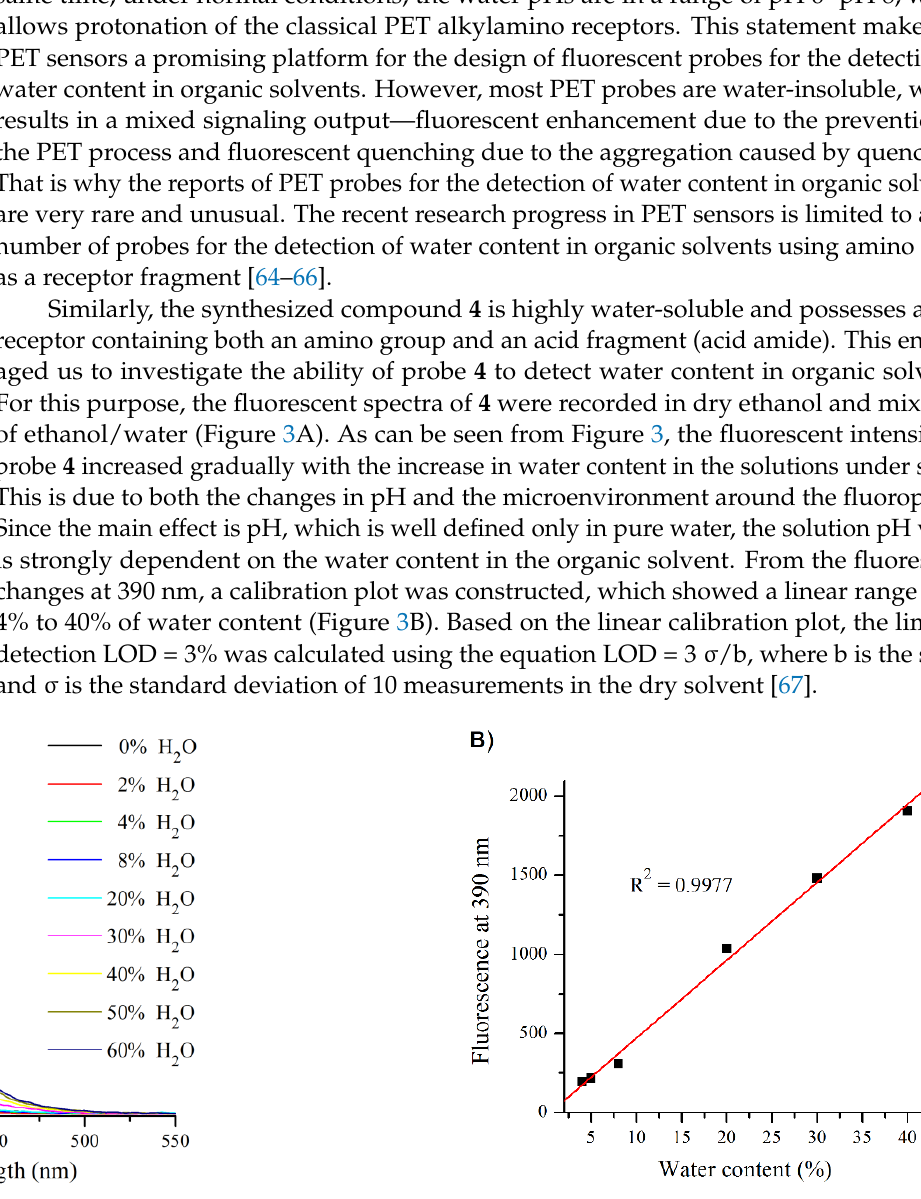
Figure 3. ( A ) Fluorescent spectra of probe 4 as a function of water content in ethanol ( λ ex = 340 nm); ( B ) Calibration plot of fluorescent changes of probe 4 at 390 nm.